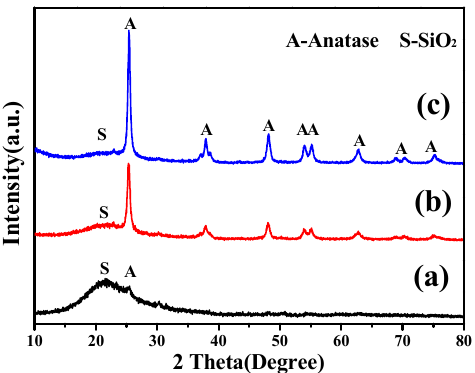
Figure 5. XRD patterns of SiO 2 –TiO 2 with different TiO 2 ratios. ( a ) 30% TiO 2 ; ( b ) 40% TiO 2 ; and ( c ) 50% TiO 2 .